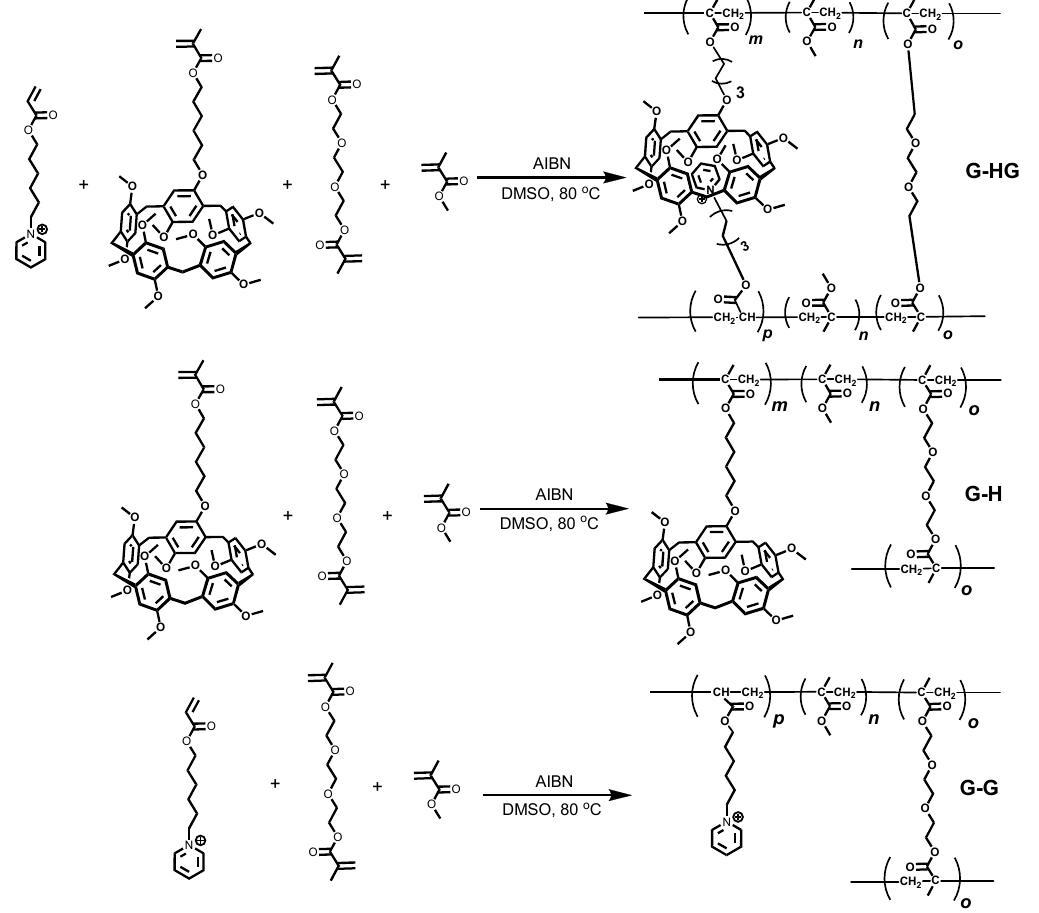
Figure 2. The synthetic routes used to obtain the G-HG , G-H , and G-G gels.